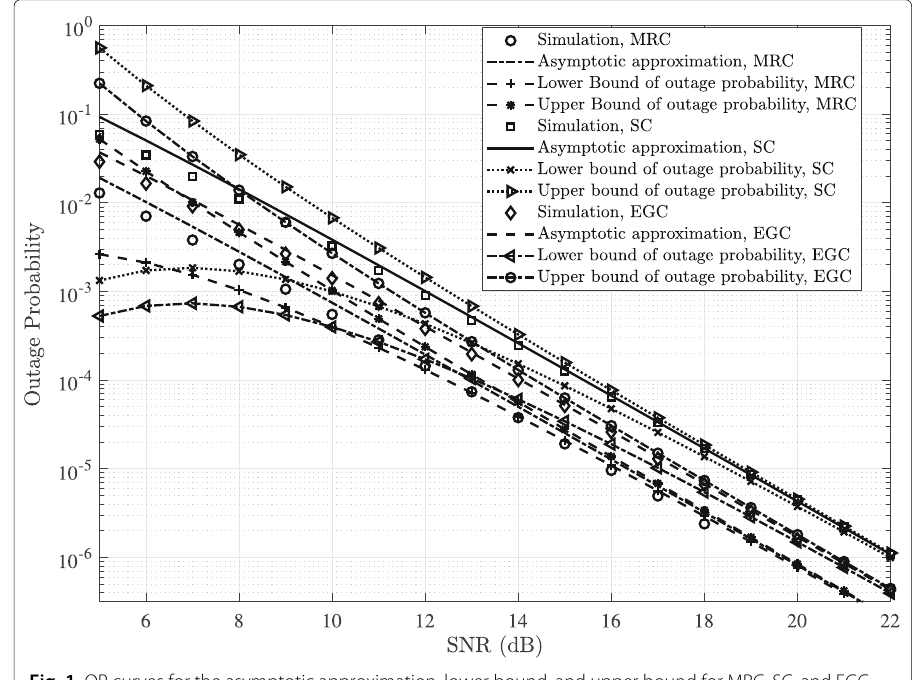
Fig. 1 OP curves for the asymptotic approximation, lower bound, and upper bound for MRC, SC, and EGC over correlated BX fading channels. The number of branches is N = 2, the fading parameter is m = 1.5, and (cid:12) C 1 , 0 2 × 2 , 0 2 × 2 ; 0 2 × 2 , C 2 , 0 2 × 2 ; 0 2 × 2 , 0 2 × 2 , C 3 the correlation structure is C b =